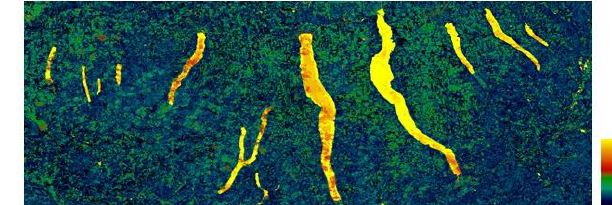
Figure 2: NDWI values ranging from Blue (-1) to Yellow (1) for the Finger Lakes Region